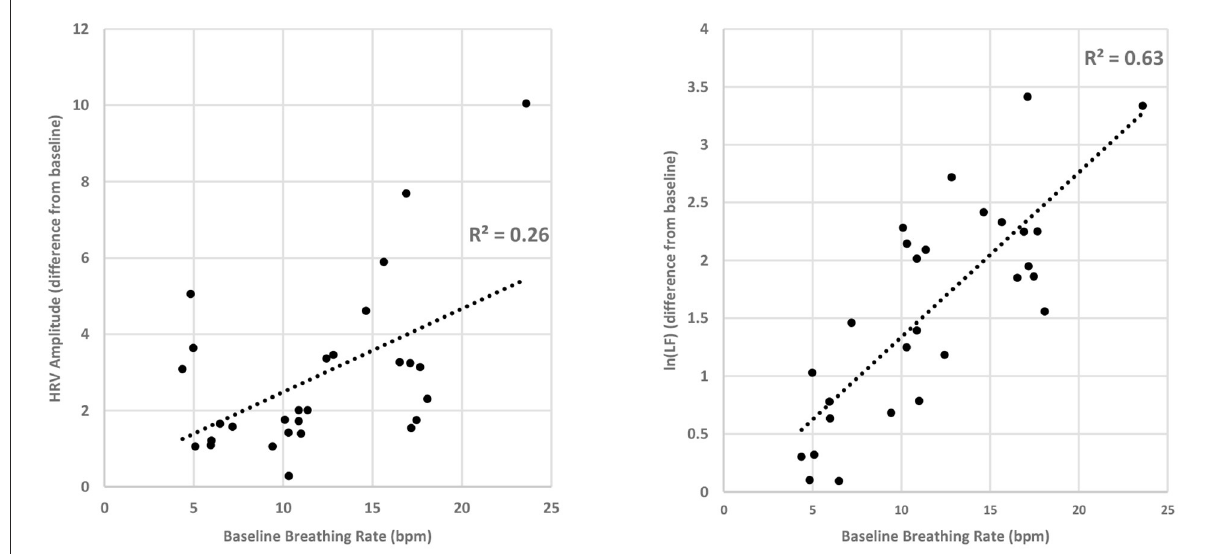
FIGURE8 Correlation plots between baseline breathing rates and mean-difference transformed HRV scores. (Left) Mean-difference transformed HRV amplitude by baseline breathing rate . (Right) Mean difference transformed ln(LF) scores by baseline breathing rate. Consistently across both measures of HRV, a significant Pearson correlation was found. This suggests that larger magnitude increases in HRV scores were created by individuals with higher baseline breathing